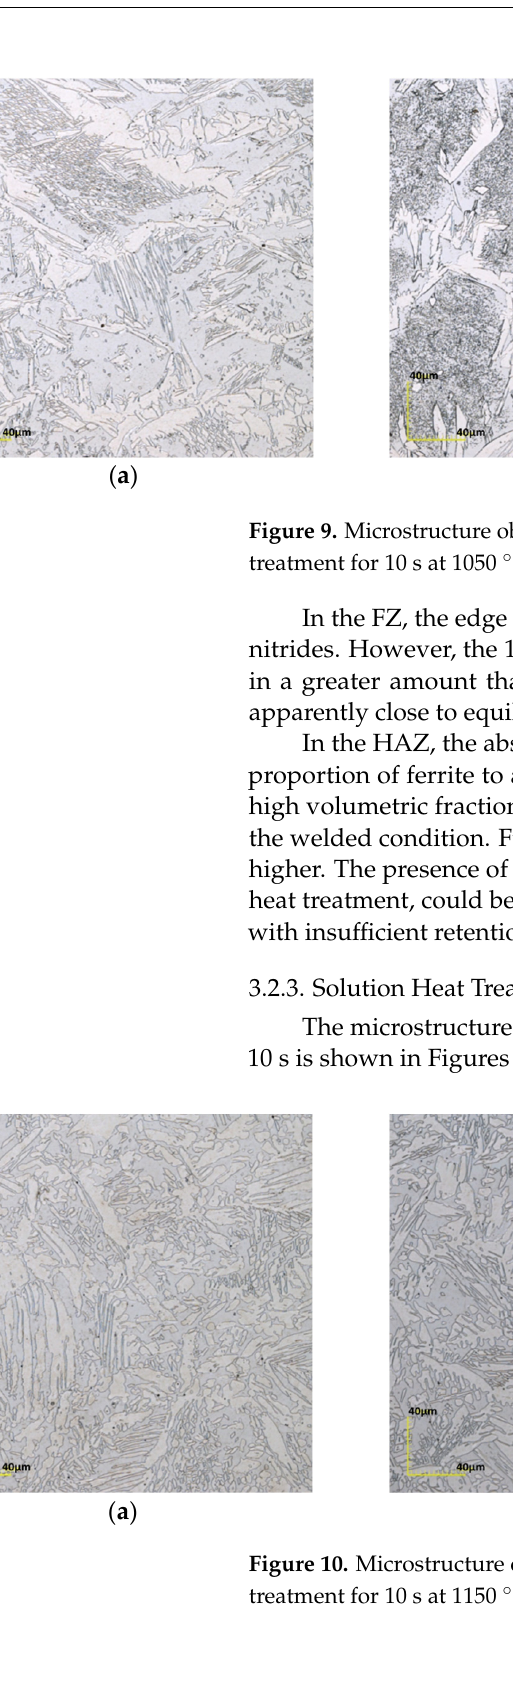
( c ) Figure 11. Microstructure observed in the HAZ of the sample subjected to postwelding solution heat treatment for 10 s at 1150 °C: ( a ) edge; ( b ) 1/4 region; ( c ) 1/2 region. In this condition, the edge, as well as the 1/4 and 1/2 regions, did not present nitrides in a significant amount in their microstructure, either in the FZ or HAZ. Thus, we found that the chromium nitrides were significantly solubilized in the ferritic matrix after the induction solution heat treatment in the different weld regions analyzed. Thus, we af- firmed that PWHT promoted the dissolution of the nitrides [26]. PWHT also caused an increase in austenite content, and this behavior was the same for edge, 1/4, and 1/2 regions. In the FZ, the austenite content became higher than that of ferrite but maintained a proportion considered acceptable. In the HAZ, there was a bal- ance between the proportions of ferrite and austenite. We also noted the presence of dif- ferent austenite morphologies: WA, IGA, and GBA. 3.3. Methods Used 3.3.1. Manual Method In general, all samples presented ferrite percentage values within the recommended range of 30% to 70%. The exceptions were the entire HAZ of the welded condition, which presented a phase imbalance, as expected, and the edge of the weld zone of the sample treated at 1050 °C for 10 s, which presented values very close to the lower limit of 30% (namely, 28%). The reference condition showed high levels of ferrite in the HAZ in all regions of the weld (reaching 75%), corroborating what was qualitatively observed in the microstruc- tural characterization; while in the FZ, the percentages were close to equilibrium.